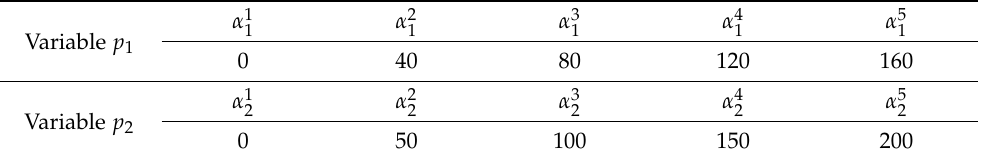
Table 3. Parameters of fuzzy sets of antecedent variables.